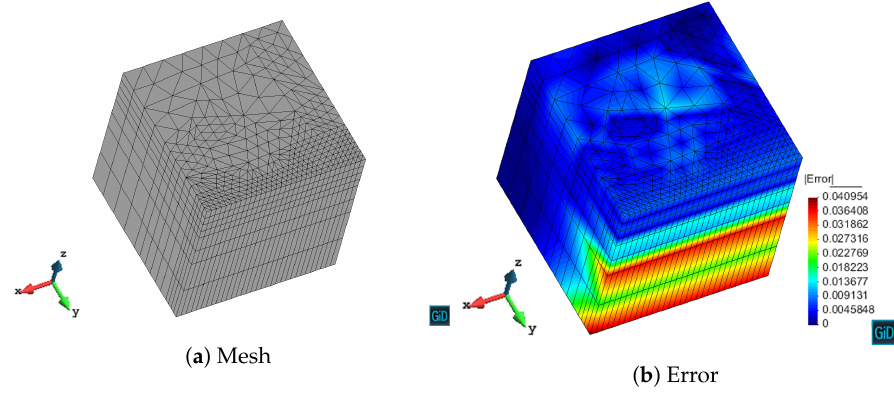
Figure 4. Treatment of eyes in the refined mesh.